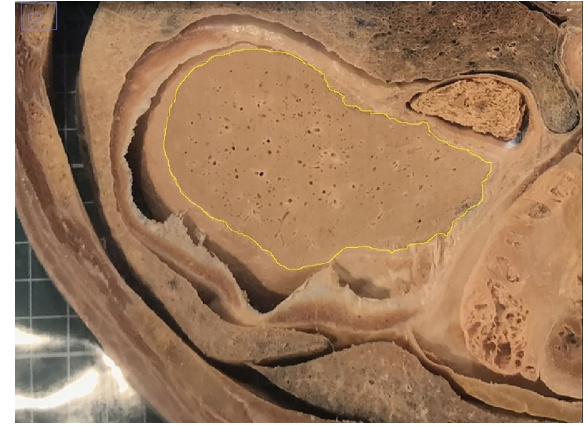
Figure 2. Measurement of the area (cm 2 ) of the liver on the upper side of the slice before forced impregnation by the ImageJ program. The yellow demarcation and the measuring scale (one centimeter) is reported in the software for